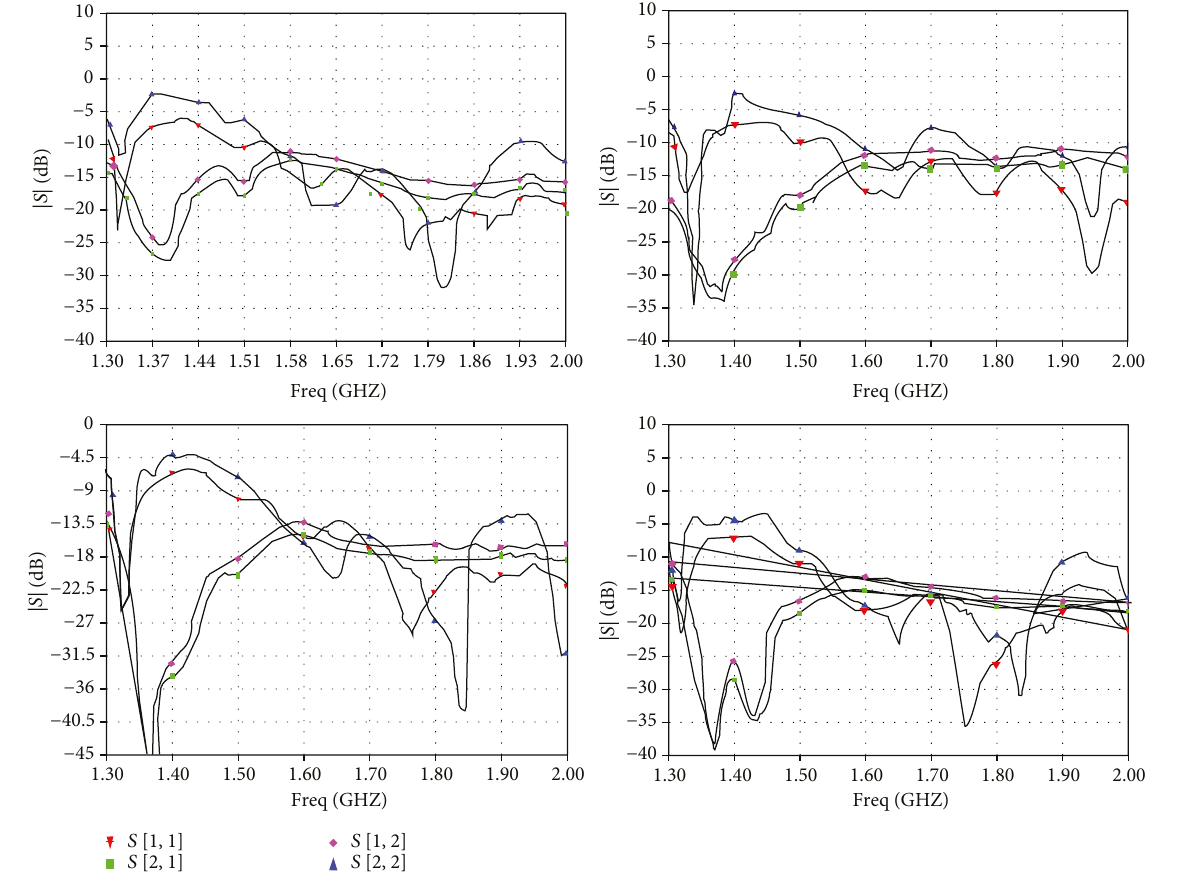
Figure 13: Measured S -parameters of the dual-element antenna array.